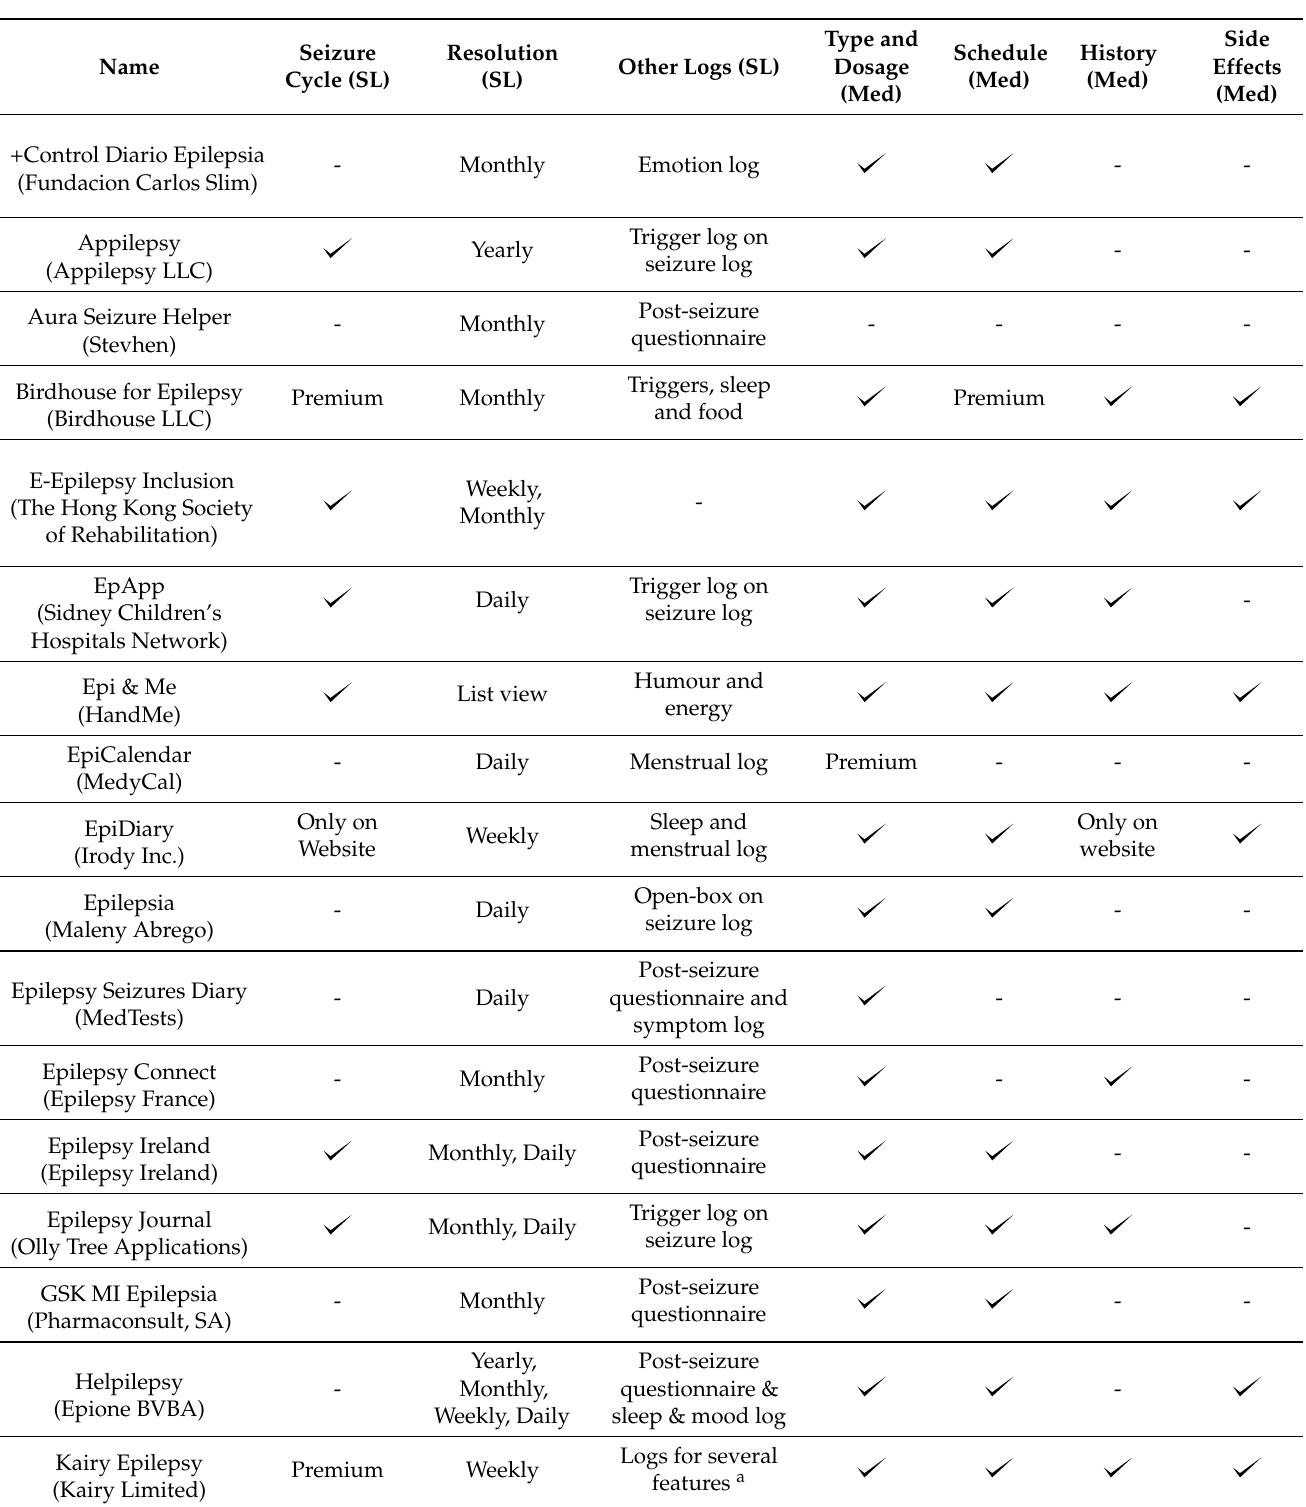
Table A2. In-depth features related to seizure log (SL) and medication (Med). Epilepsy mobile applications for self-management and seizure detection (only remaining candidates, as selected in Table